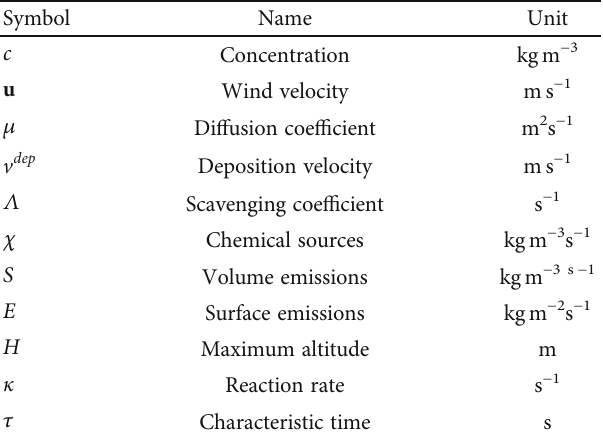
Table 1: Fields and physical parameters of the model.